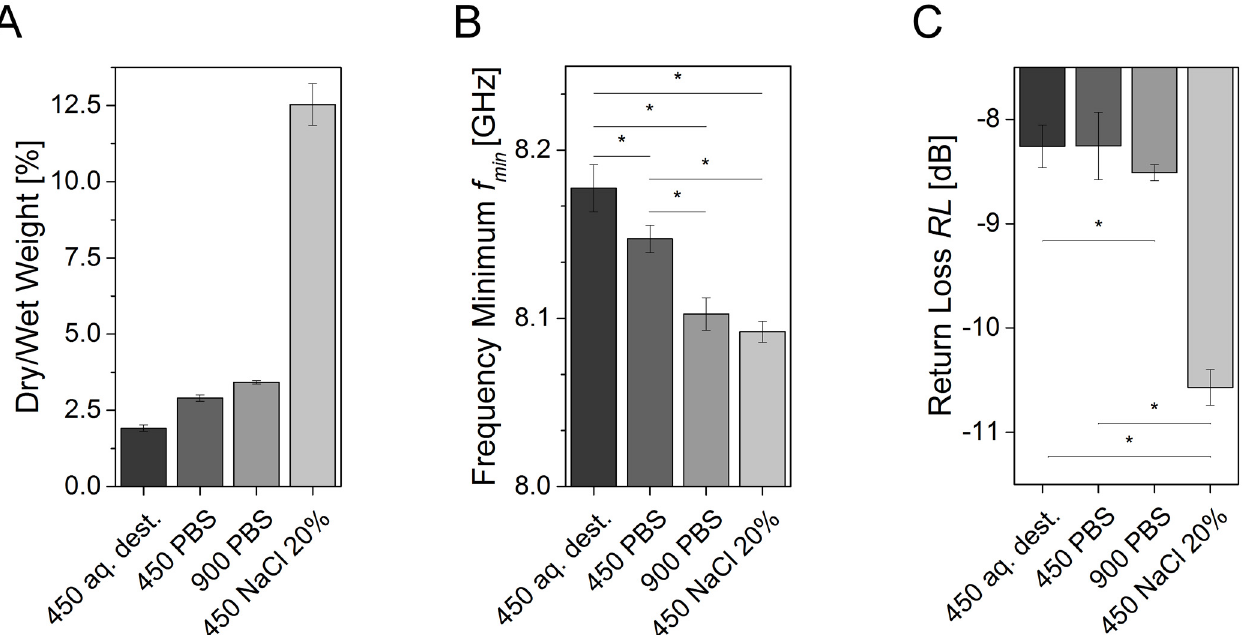
Fig 4. Microwave reflection signal of dermal equivalents at different osmolalities and cell concentrations. (A) Comparison of dry to wet weight ratio demonstrated that the weight of the dry component increased with a higher osmolality and cell concentration of the remaining substances. (B) f min declined at higher cell concentrations (from 4.5x10 5 to 9x10 5 cells) and osmolalities, mimicking hypo-, iso- and hypernatraemia. (C) In analogy to f min , RL dropped with a higher osmolality. Bar diagrams show mean values, error bars depict standard deviation. Asterisks indicate statistical relevant differences ( p -value (cid:2) 0.5). Each group comprised 3 individual samples that were measured in triplicate.